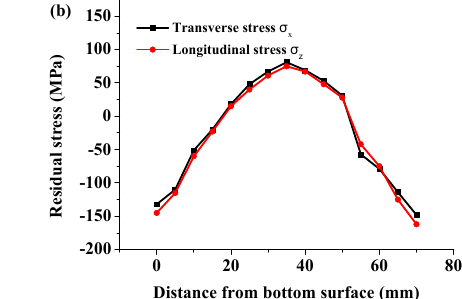
Figure 8. Residual stress distribution of the integral and five-pass stepwise cold pressing process: ( a , c ) is transverse and longitudinal residual stress after integral pressing, respectively; ( b , d ) is transverse and longitudinal residual stress after 5th stepwise pressing, respectively.